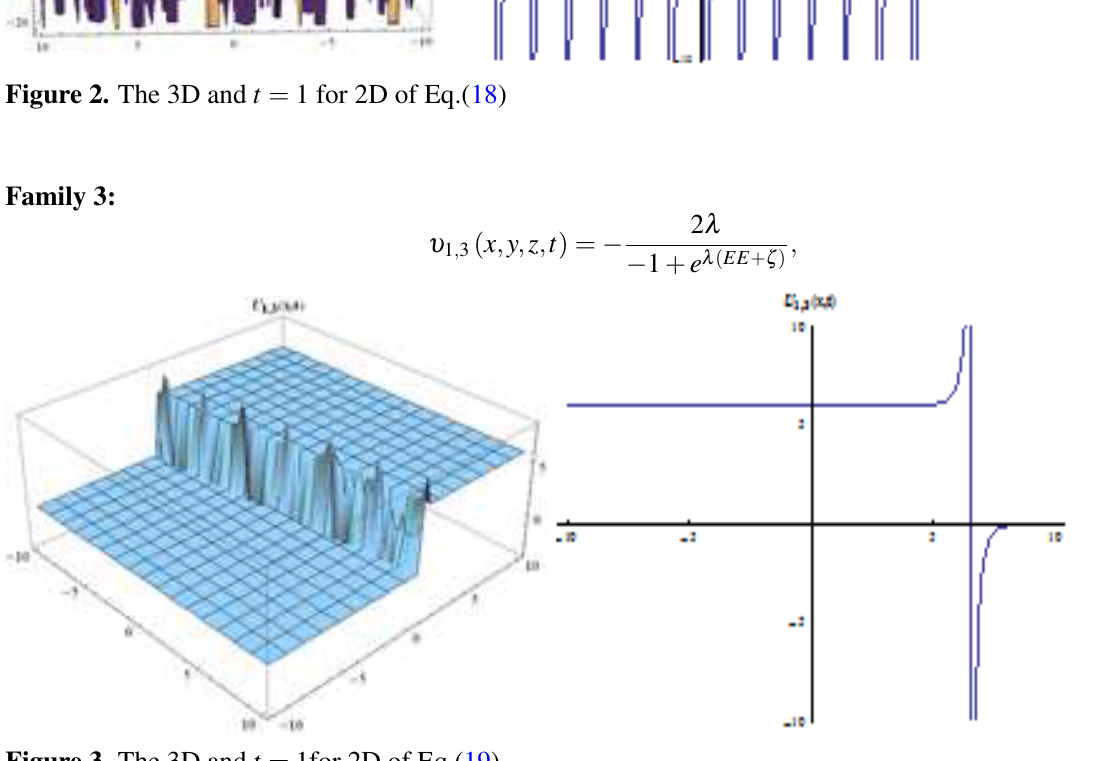
Figure 3. The 3D and t = 1for 2D of